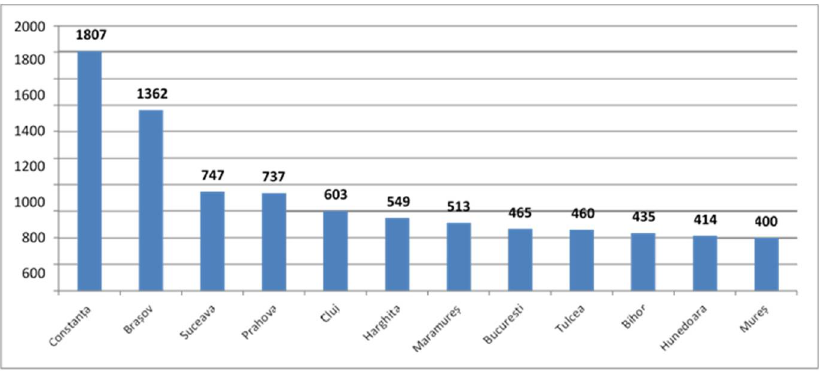
Figure 3. Number of tourist reception structures with accommodation functions, by county (Decem- ber 2018). Source: http://turism.gov.ro/web/autorizare-turism/ accessed date 20 April 2021.